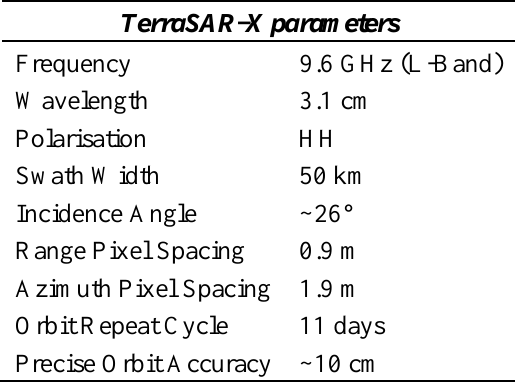
Table 5. TerraSAR-X parameters used in this